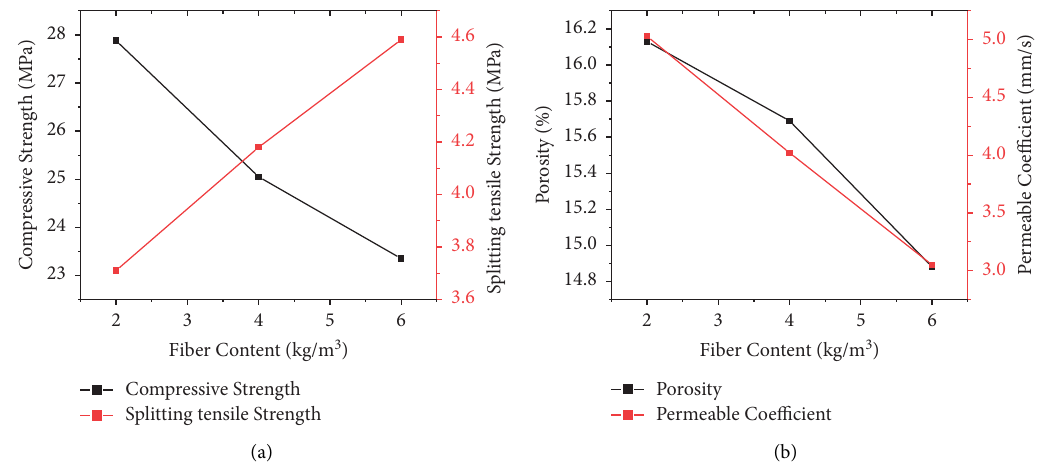
Figure 15: Line chart of infuence of diferent content of basalt fber on performance of pervious concrete. (a) Relationship between fber content and mechanical properties. (b) Relationship between fber content and water